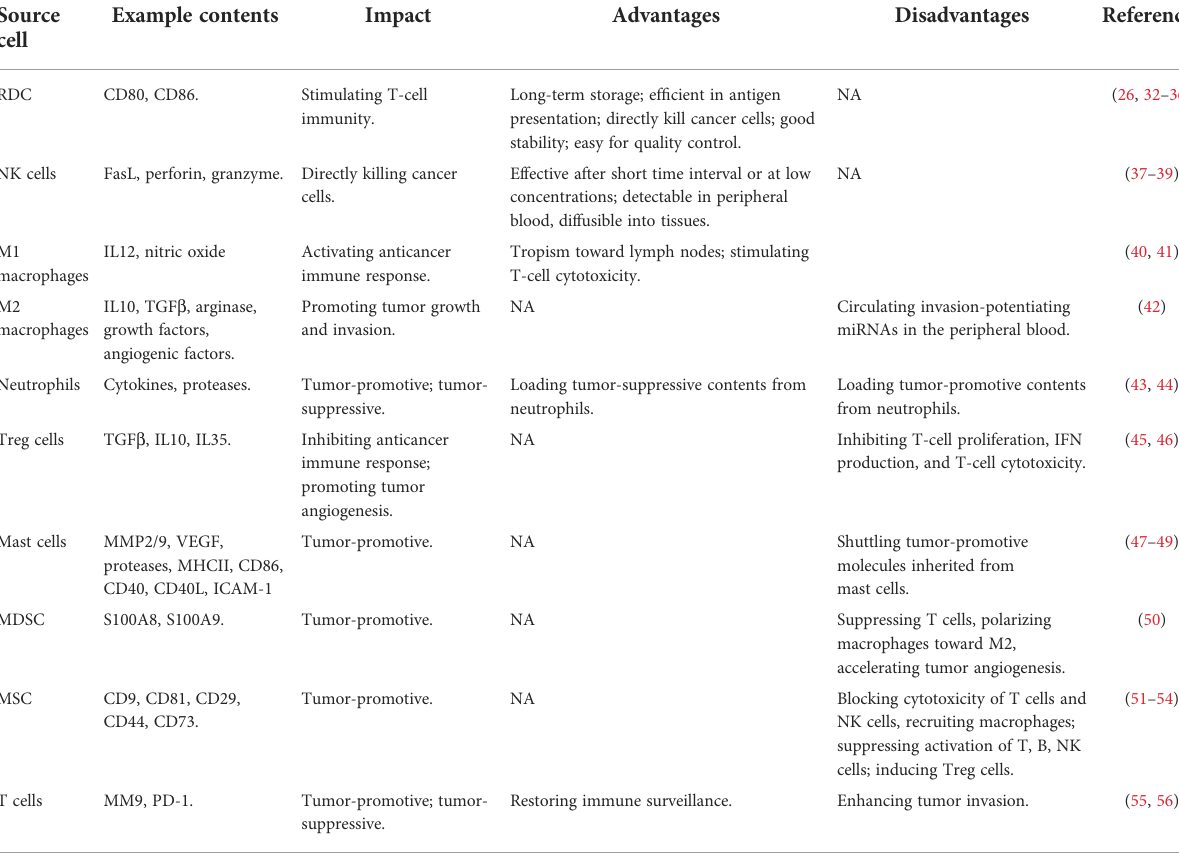
TABLE 1 Advances and limitations of using exosomes originated from different immune cells for cancer